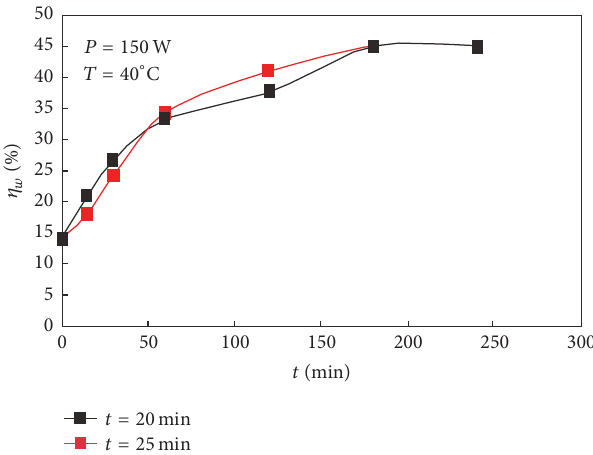
Figure12:Theimpactofdifferentultrasonictreatmenttime(20 min and 25min) on sonochemistry